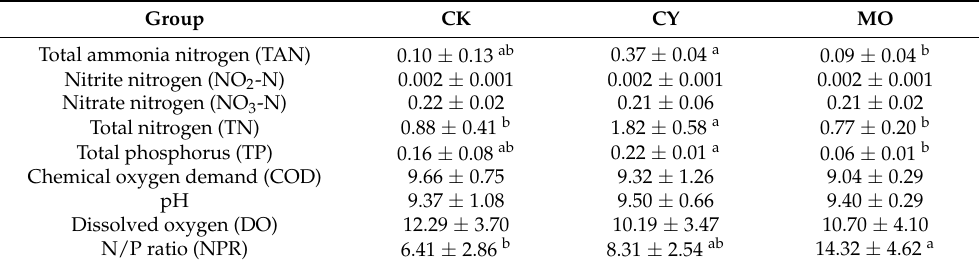
Table 1. Description statistic of water quality parameters and their variations across different groups. CK denoted normal group, CY denoted cyanobacteria bloom group, and MO denoted pond moss group. Values are presented as means ± SD. Statistically significant differences are indicated by different letters ( p < 0.05).